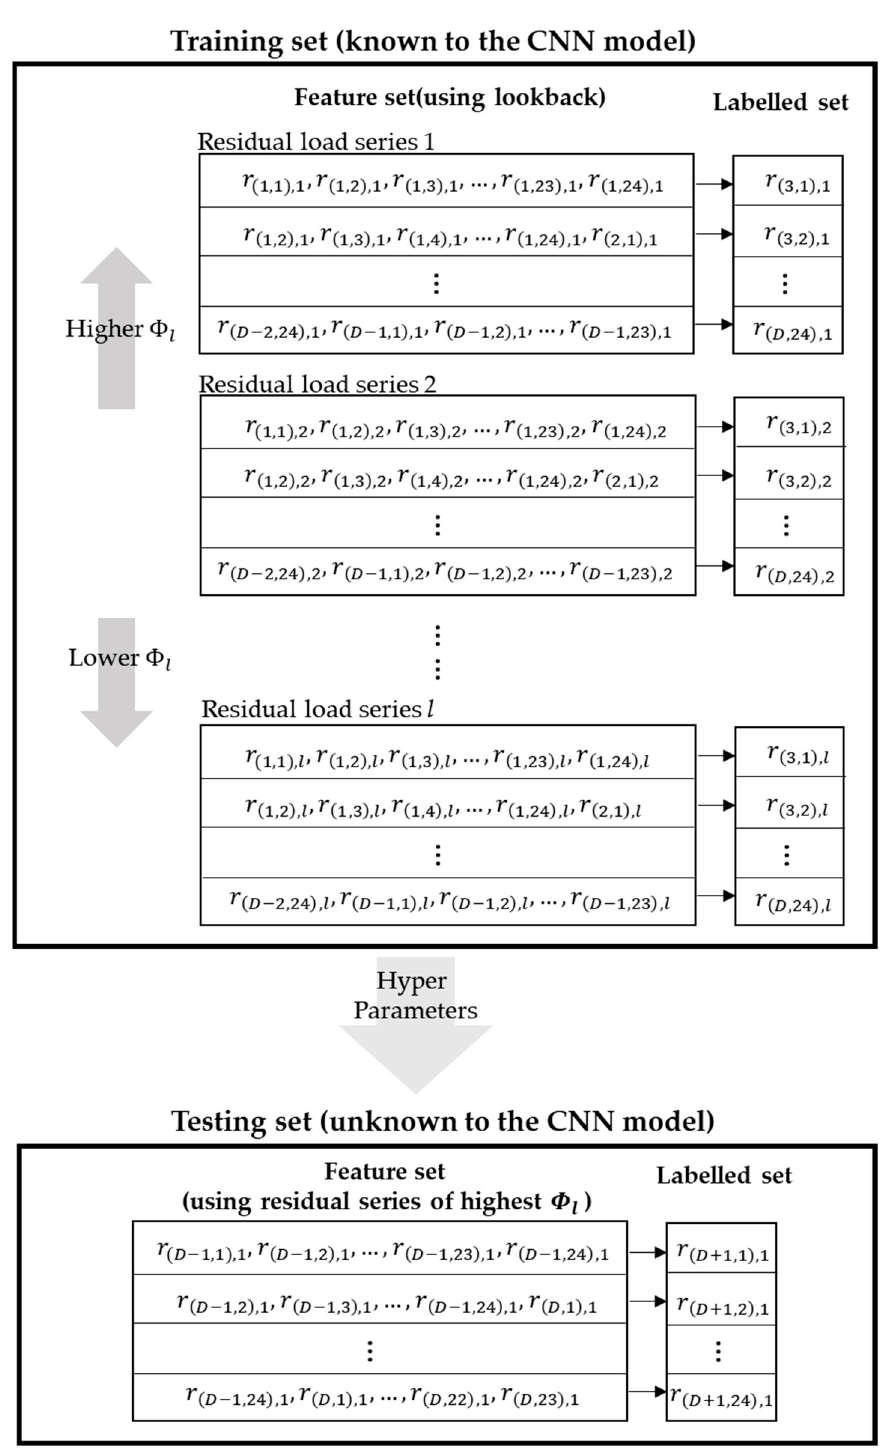
Figure 6. Structure of training and testing data for the proposed method.